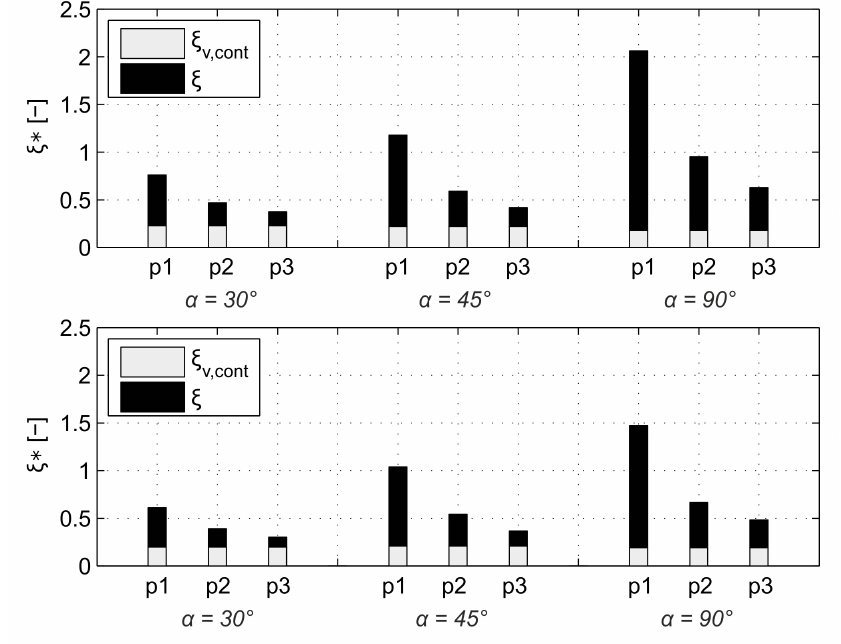
Figure 7. Proportion of head loss coefficient ξ v , cont through the supporting structure and friction and ξ for rack option CBTR ( above ) and FFF ( below ) on the total head loss coefficient ξ ∗